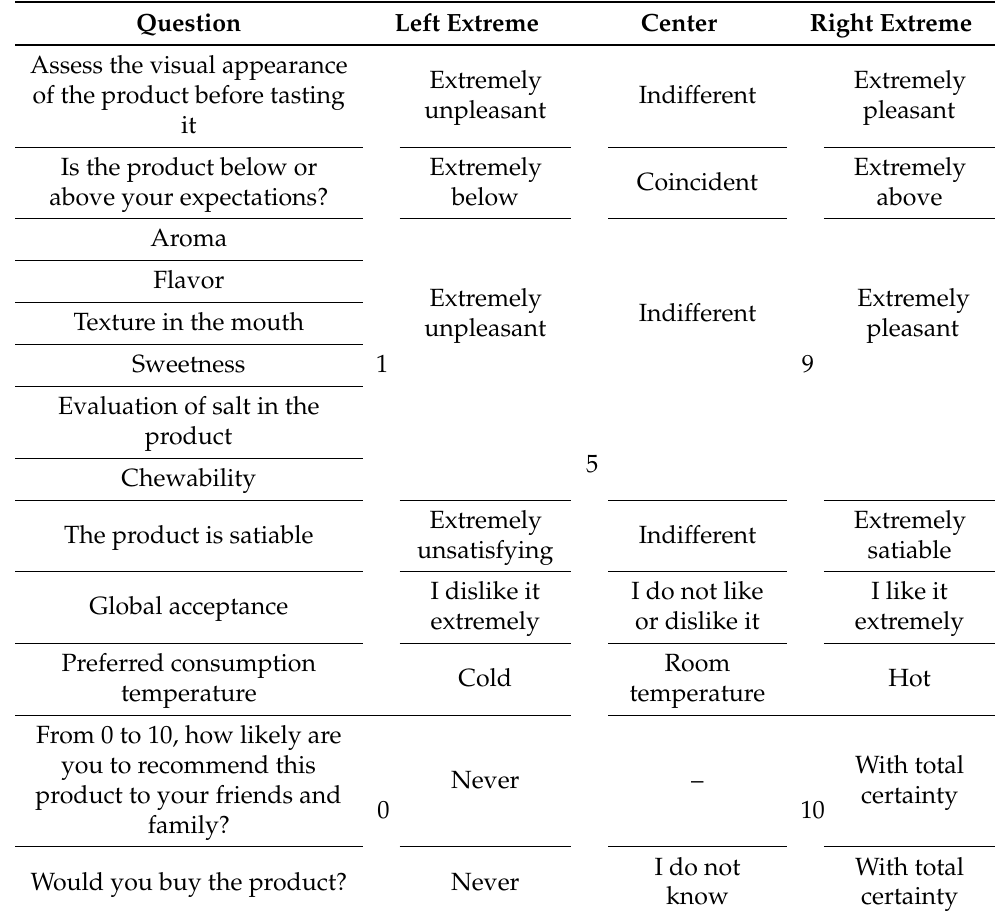
Table 5. Questions of the self-report questionnaire and corresponding scales used with the labels of the extremes and middle point